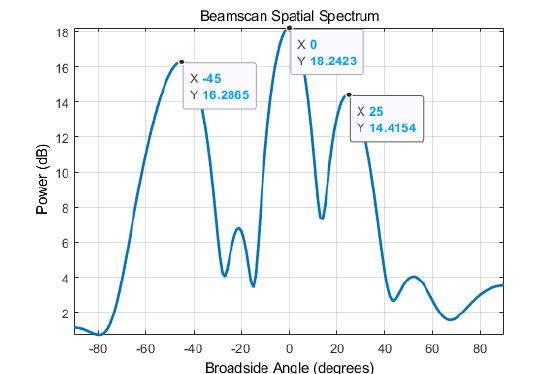
Figure 3. Simulated AoA Estimation Spectrum.